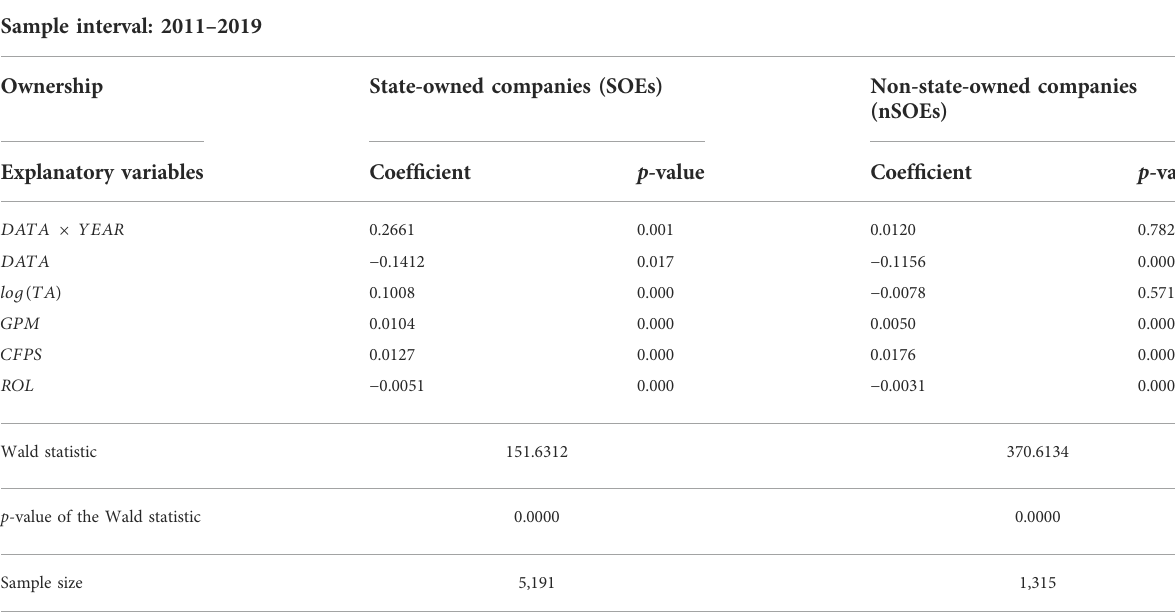
TABLE9ImpactofDPFadoptiononearningspershare(ownershipheterogeneitymodelwithregressionresultsforSOEsandnon-SOEclassi fi